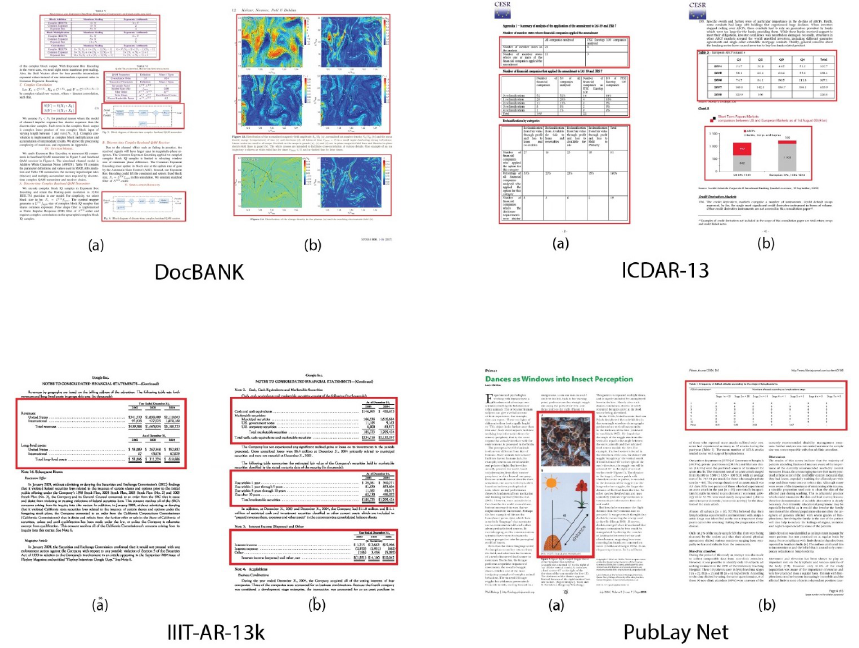
Figure 10. Sample document images taken from the various datasets of DocBank [13], ICDAR-13 [38], IIT-AR-13K [51], and PubLayNet [9]. Part ( a , b ) represent the highlighted graphical page objects in a document image.